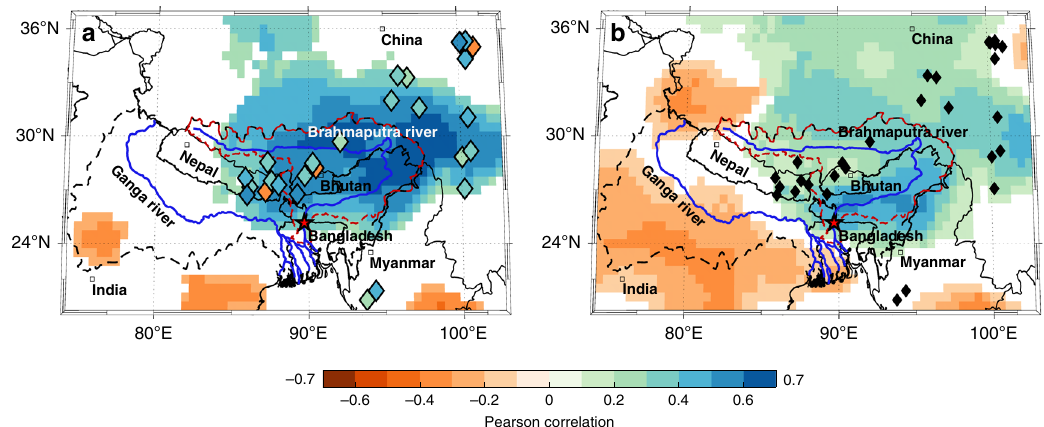
Fig. 1 Climate-stream fl ow-tree-growth relationships in the Brahmaputra watershed (red dashed lines). The fi gures also highlight the larger Ganga – Brahmaputra – Meghna watershed (black dashed line), and the locations of the 28 tree-ring predictors (diamonds) used in the mean July – August – September (JAS) stream fl ow reconstruction at the Bahadurabad gauge, Bangladesh (red star). a In fi ll shading in diamond markers represent the Pearson correlation between mean JAS discharge at Bahadurabad and each tree ring predictor (1956 – 1998 C.E.). Background shading is the spatial fi eld correlation between mean JAS discharge at Bahadurabad and mean JAS precipitation (1956 – 2011 C.E.) b Spatial fi eld correlation between the fi rst principal component (PC1) of the 28 tree ring predictors (variance explained: 24.86%) and mean JAS precipitation (1956 – 1998 C.E.). Spatial correlations in ( a ) and ( b ) are against CRU Ts 4.01 precipitation. Together, ( a ) and ( b ) show that monsoon season JAS fl ow in the Brahmaputra is positively related to upper basin precipitation in a region largely co-located with the tree ring predictor network. They also demonstrate that the predictor network effectively captures regional JAS precipitation independent to its correlation with JAS Brahmaputra discharge. Note that the locations of predictors are jittered for display. Only correlations signi fi cant at p < 0.05 using a 2-tailed t -test are shown. See Supplementary Table 1 for more information on the predictor network and Supplementary Fig. 2 for similar analyses with GPCC